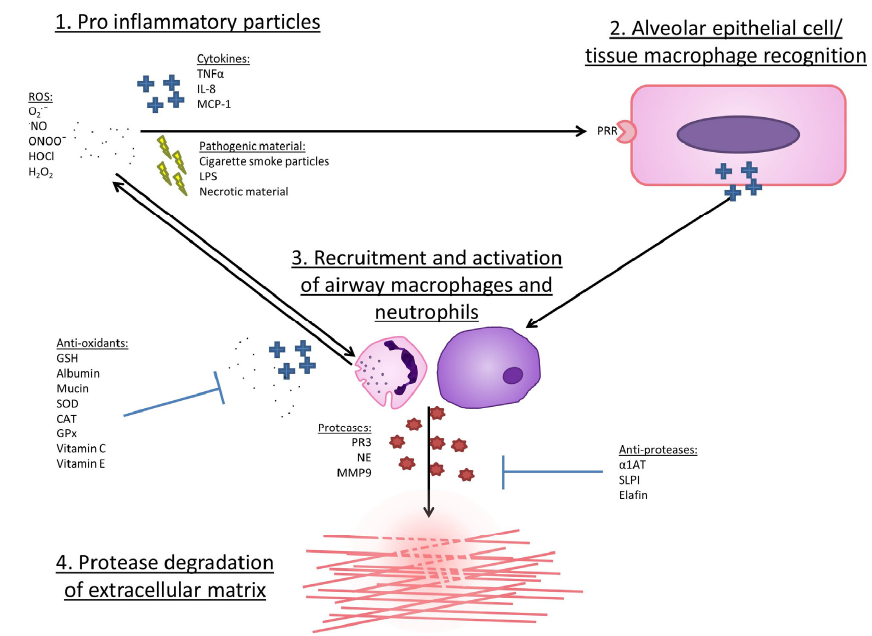
Figure 2. Process of tissue damage in chronic obstructive pulmonary disease (COPD). 1. Influx of pro-inflammatory particles into lung. 2. Particles bind PRRs on the surface of lung epithelial